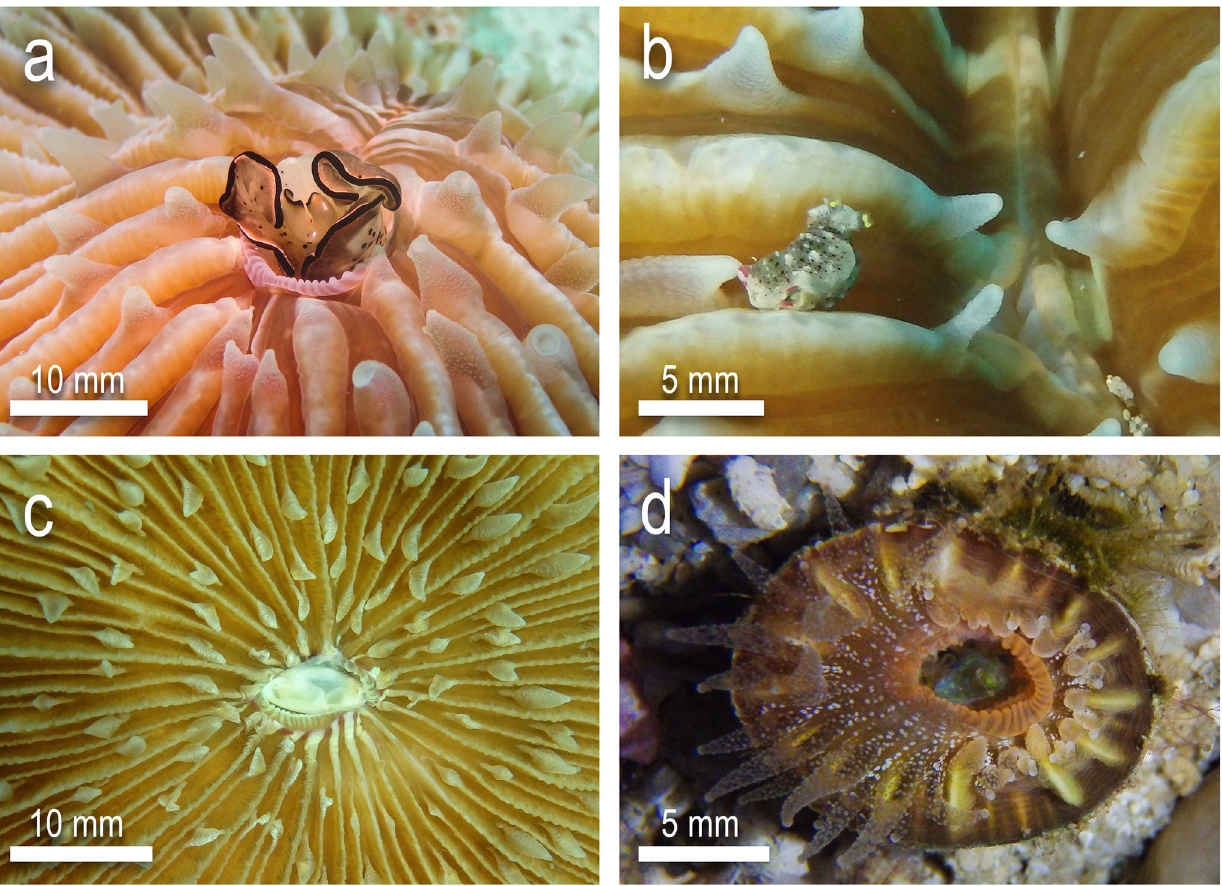
Fig 8. Examples of additional test trials with a) Elysia marginata and Fungia fungites , b) Elysia asbecki with F . fungites , c) Aliculastrum debile with F . fungites and d) Elysia pusilla with Truncatoflabellum sp.